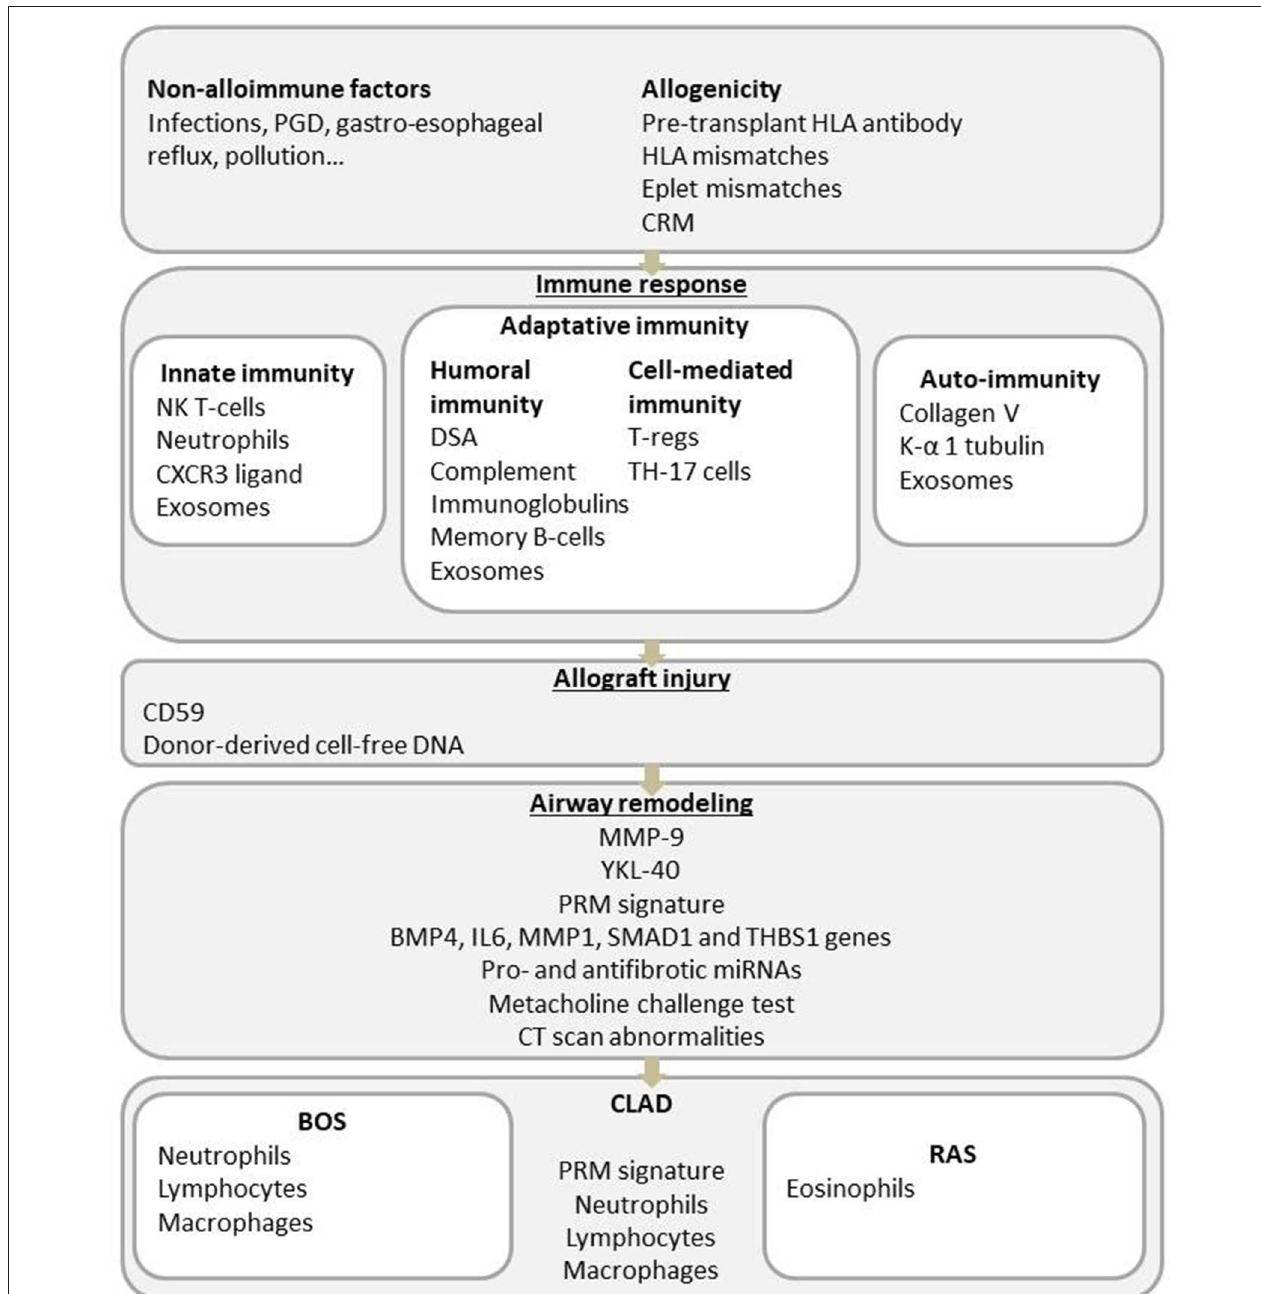
FIGURE 1 | Main physiopathologic mechanisms involved in CLAD, with associated potential